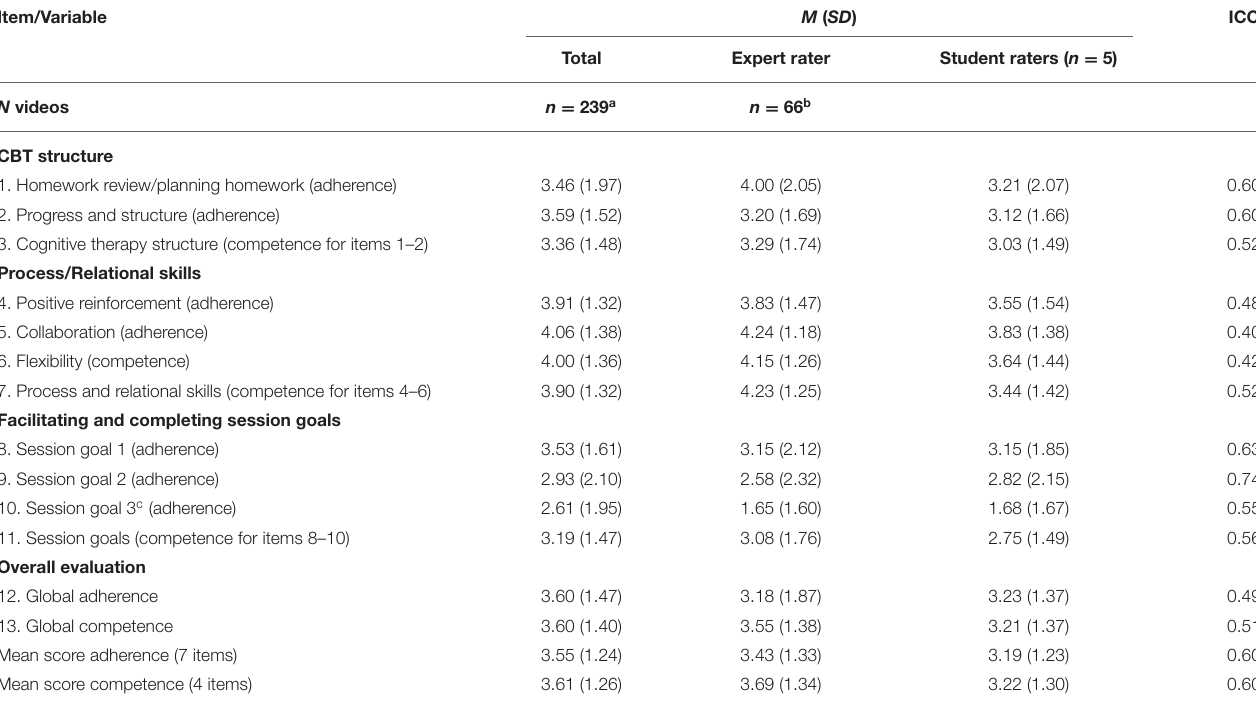
TABLE 2 | Inter-rater reliability between expert and student raters for the 11-item CAS CBT scale and mean adherence/competence.